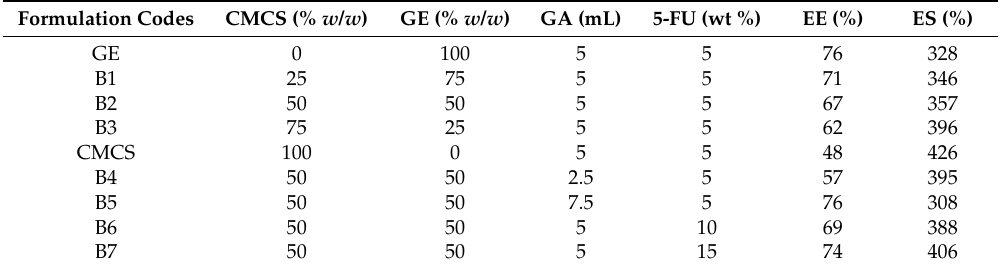
Table 1. Formulation parameters of blend hydrogel microspheres of GE with CMCS along with % encapsulation efficiency (EE) and % equilibrium swelling (ES) data at 37 ◦